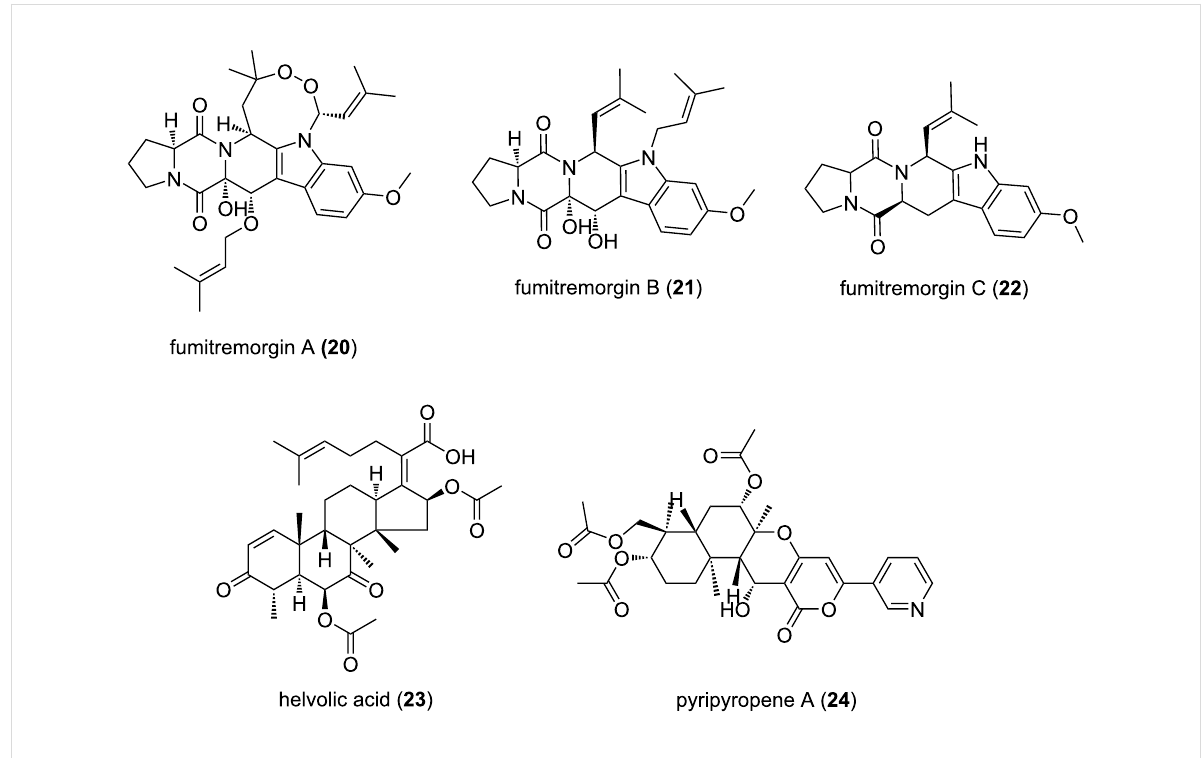
Figure 7: Bioactive secondary metabolites of Aspergillus fumigatus